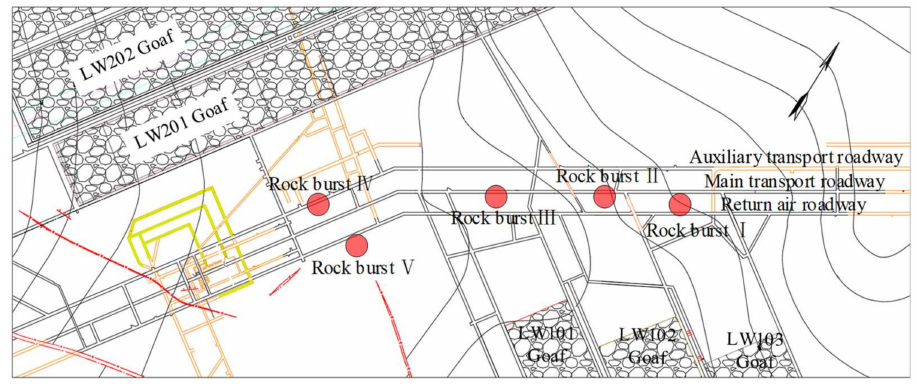
Figure 12. Roadway layout and rock bursts distribution in Gaojiapu Coal